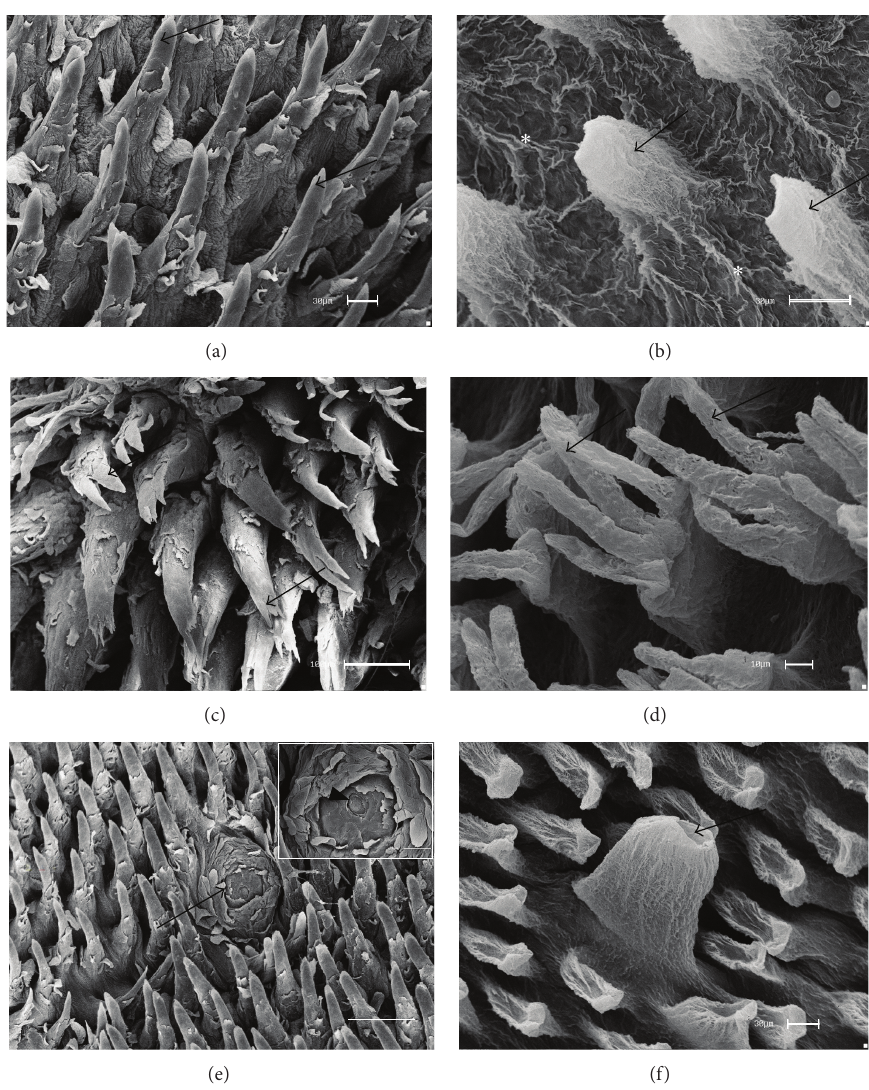
Figure 1: Scanning electron micrographs—filiform and fungiform papillae of rats. (a) Conical filiform (arrows) and (b) after maceration with NaOH the CTCs of the filiform papillae presented conical (arrows) and bundles ( ∗ ) in the interpapillary zone. (c) Multifilamentary papillae (arrows) and (d) their CTCs revealed three to four filaments (arrows) in the third upper part. (e) The fungiform papillae (arrow) exhibited dome-like shape between conical filiform papillae and the highlighted taste orifice (arrowhead) may be seen in the surface. (f) After the removal of the epithelium, the CTCs of the fungiform papillae revealed volcano-like shape, with a cavity on the top for the taste buds (arrow). Bars: 30 𝜇 m (a, b, f), 100 𝜇 m (c, e), and 10 𝜇 m